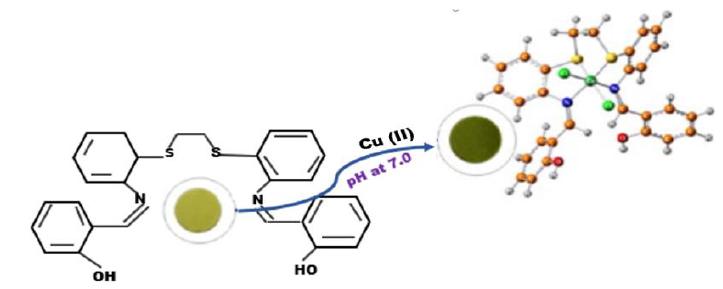
Figure 3. Efficient meso-adsorbent prepared for trace Cu (II) detection and removal [9]. Figure 3. E ffi cient meso-adsorbent prepared for trace Cu (II) detection and removal